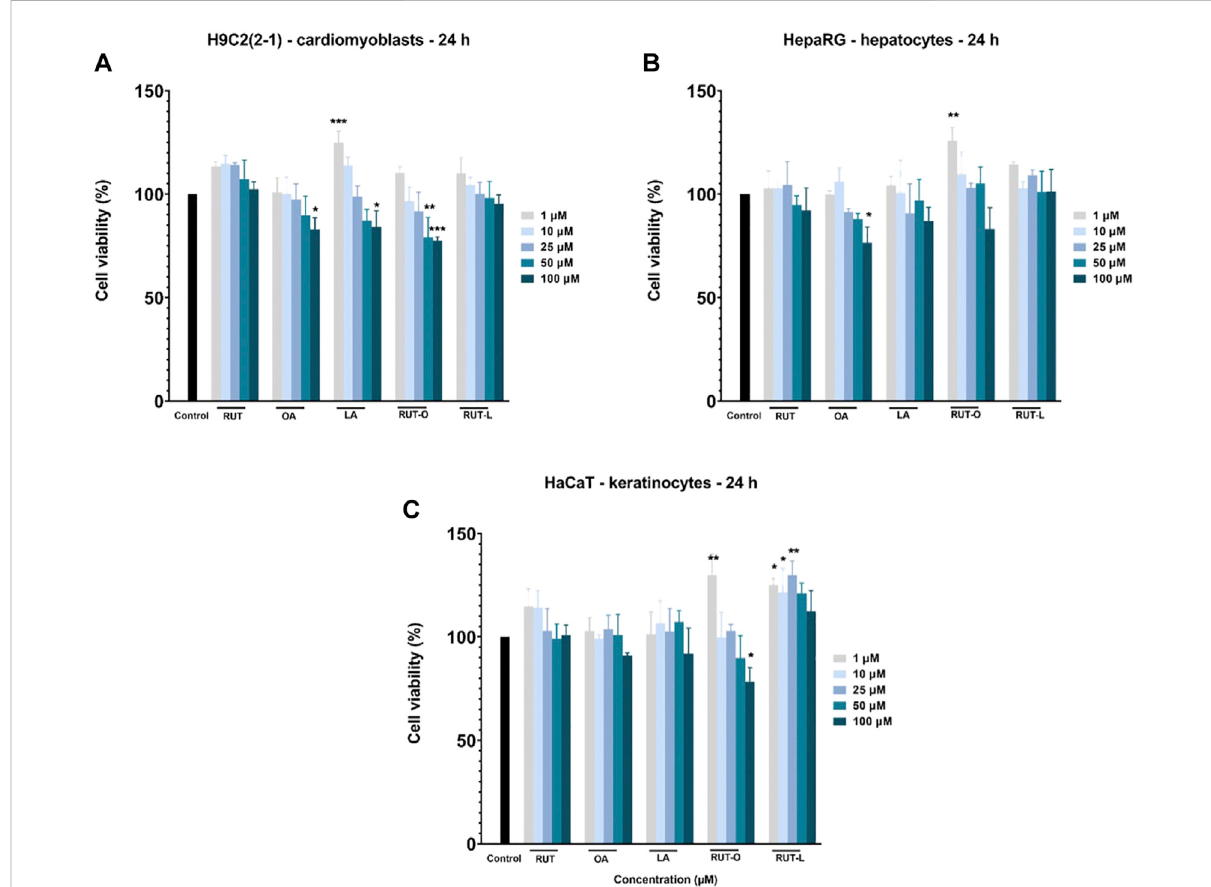
FIGURE 3 In vitro cell viability evaluation of theparentcompounds (PCs) and rutin esters (REs)in healthy (A) cardiomyoblasts — H9c2(2-1), (B) hepatocytes - HepaRG, and (C) keratinocytes - HaCaT cells after 24 h of treatment by performing the MTT assay. Five concentrations were selected for this assay — 1, 10, 25, 50, and 100 µM. Data are presented as viability percentages (%) normalized to control (untreated cells) and are expressed as mean values ±SD of three independent experiments performed in triplicate. The statistical differences between control and the treated group were veri fi ed by applying the one-way ANOVA analysis followed by Dunnett ’ s multiple comparisons post-test. The statistically signi fi cant differences between data are marked with * (* p < 0.05; ** p < 0.01; *** p <